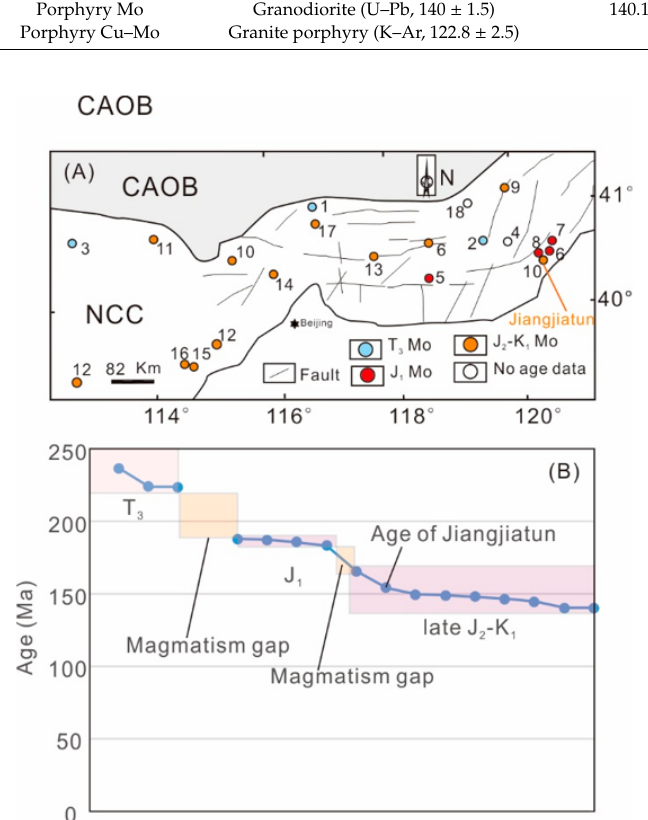
Figure 7. The summary of ages of the Mesozoic Mo deposits in the Yan-Liao metallogenic belt (YLMB), North China craton. Two age gaps of magmatism are identified in this area during Mesozoic. ( A ) The spatial distribution of the Mo deposits in the YLMB; ( B ) The comparative age diagrams of the Mo mineralization events in the YLMB. Abbreviations: CAOB—Central Asian Ocean Belt, NCC—North China Craton. The meanings of the numbers denoted in the diagram are the same as Figure 1. Table 3. Summary of ages of the Mesozoic Mo deposits in the Yan-Liao metallogenic belt, North China Craton.